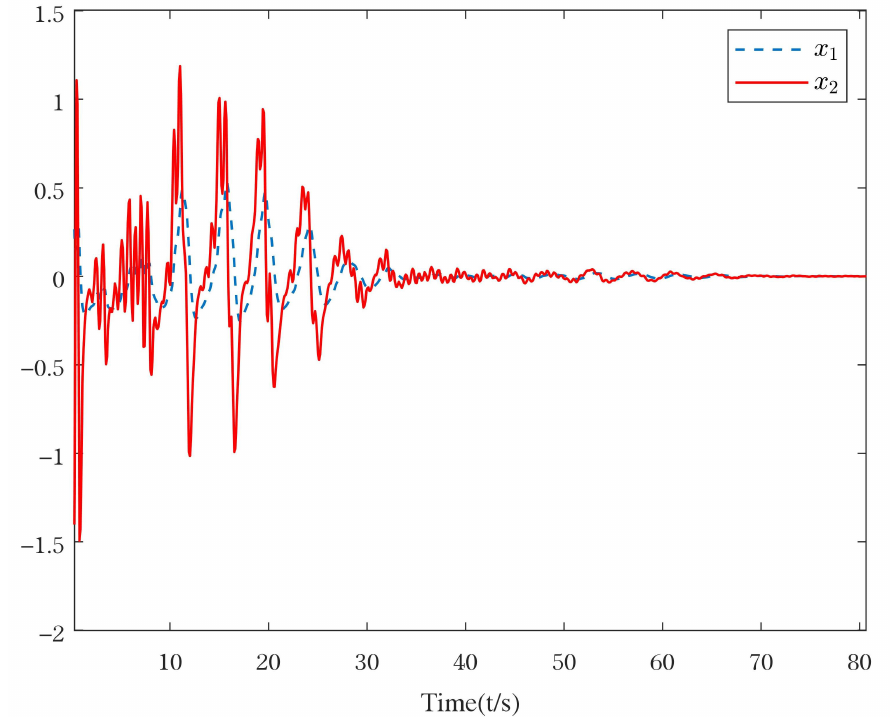
Figure 7. The evolution of x 1 ( t ) and x 2 ( t )